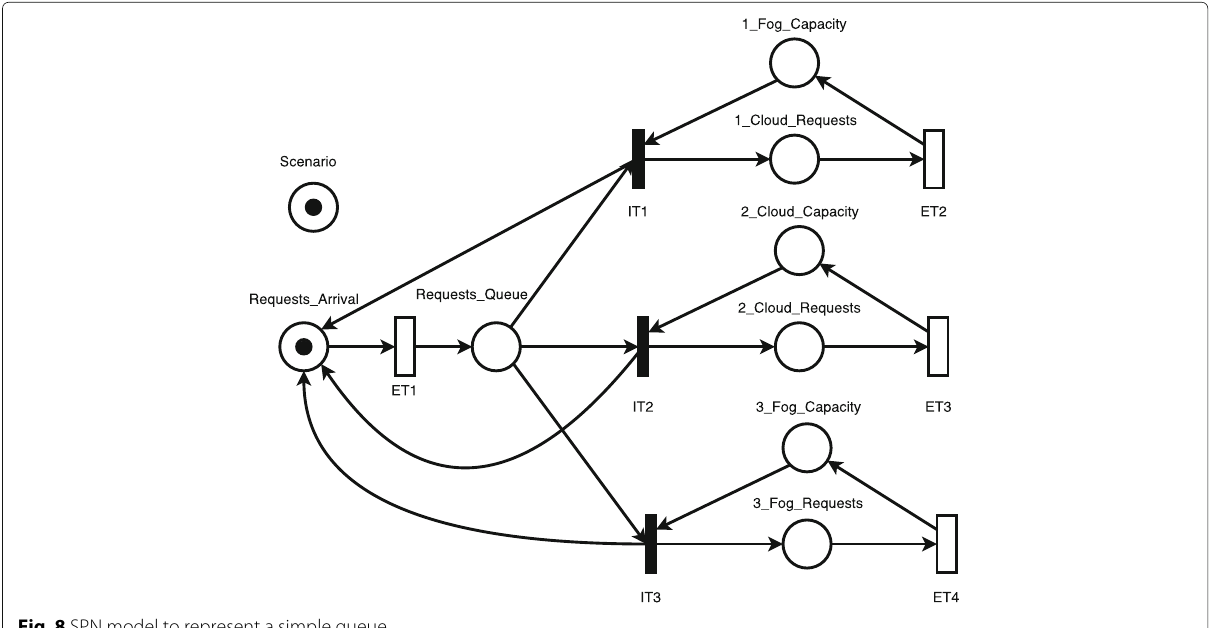
Fig. 8 SPN model to represent a simple